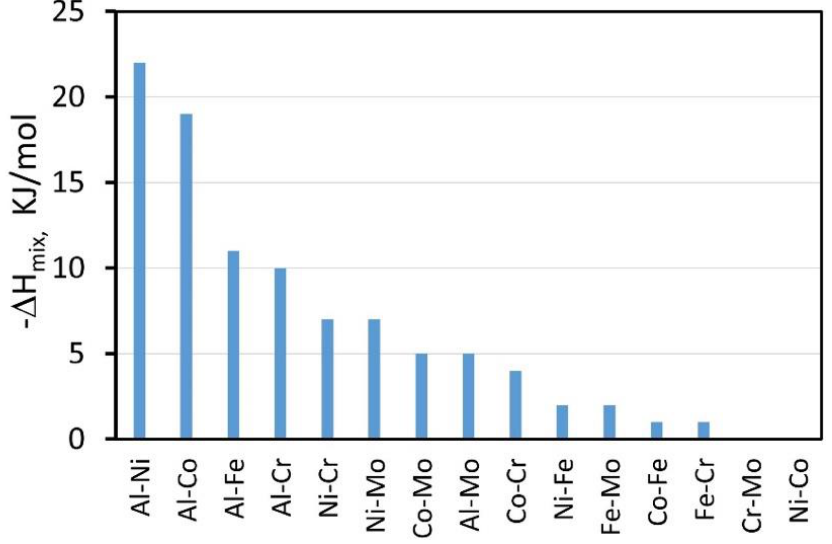
Figure 8. Negative enthalpy of mixing for the elements [37].